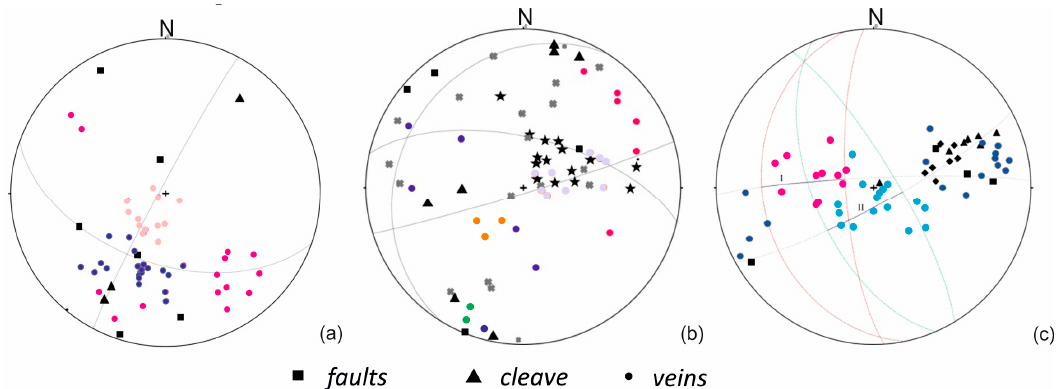
Figure 5. Stereographic projection of the distribution of structural elements, veins and veinlets of the studied systems: ( a ) Krivoy; ( b ) Beregovoy (stars indicate stratification, crosses—sub-consistent veins); and ( c ) Otvesny. The color of the icons corresponds to the color of the veins in Figures 2–4.